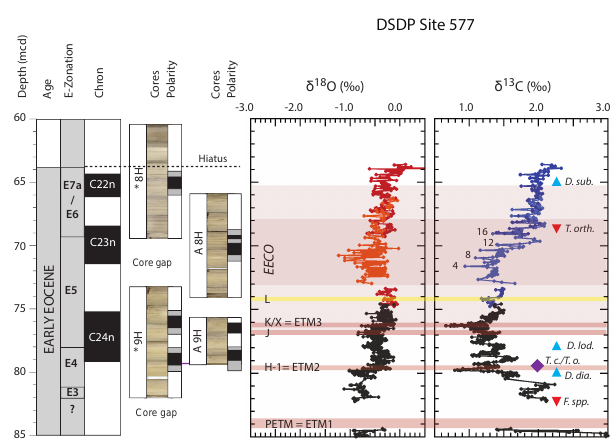
Figure 5. Cores, stratigraphy and bulk sediment stable-isotope composition for the early Eocene interval at Deep Sea Drilling Project (DSDP) Site 577 aligned according to composite depth (Dickens and Backman, 2013). Note the increased length for the gap between Core 577*-8H and Core 577*-9H (see text). The Wade et al. (2011) E-zonation, partly modified by Luciani and Gius- berti (2014), has been applied to Site 577, given assemblages pre- sented by Lu (1995) and Lu and Keller (1995). Note that (i) the base of Zone E3 (top of Morozovella velascoensis ) lies within a core gap; (ii) the E4–E5 zonal boundary (base of M. aragonensis ) oc- curs within C24n, in agreement with Luciani and Giusberti (2014); (iii) the E5–E6 zonal boundary is problematic because the top of M. subbotinae occurs in the middle of C24n, much earlier than the presumed disappearance in the upper part of C23n (Wade et al., 2011), and we have therefore positioned the E5–E6 boundary at the lowest occurrence of Acarinina aspensis , according to the original definition of Zone E5 (Berggren and Pearson, 2005); and (iv) we cannot differentiate between Zone E6 and Zone E7a due to the ab- sence of Astrorotalia palmerae and to the diachronous appearance of A. cuneicamerata (Luciani and Giusberti, 2014). Magnetostratig- raphy and key calcareous nannofossil events are those summarized by Dickens and Backman (2013). These events noted in Fig. 4 are abbreviated as follows here and in the following figures: F. spp.